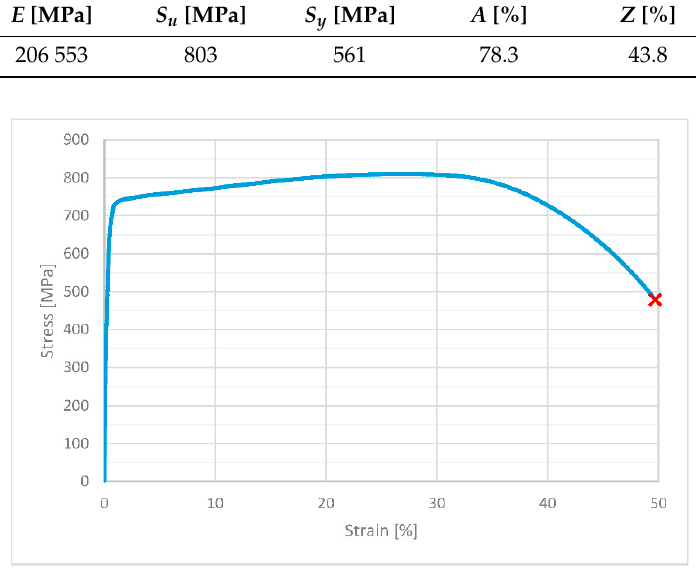
Figure 3. Stress–strain curve for static load for exemplary specimen.